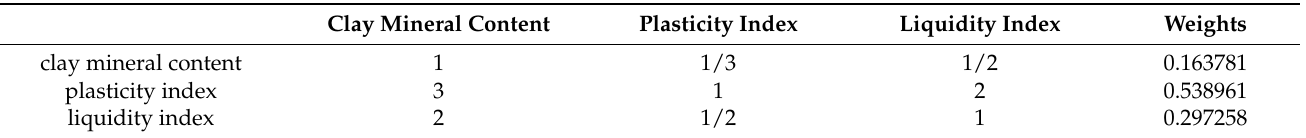
Table A3. Pairwise comparison matrix for quaternary level geological factors (b1-d) λ max = 3.0092;